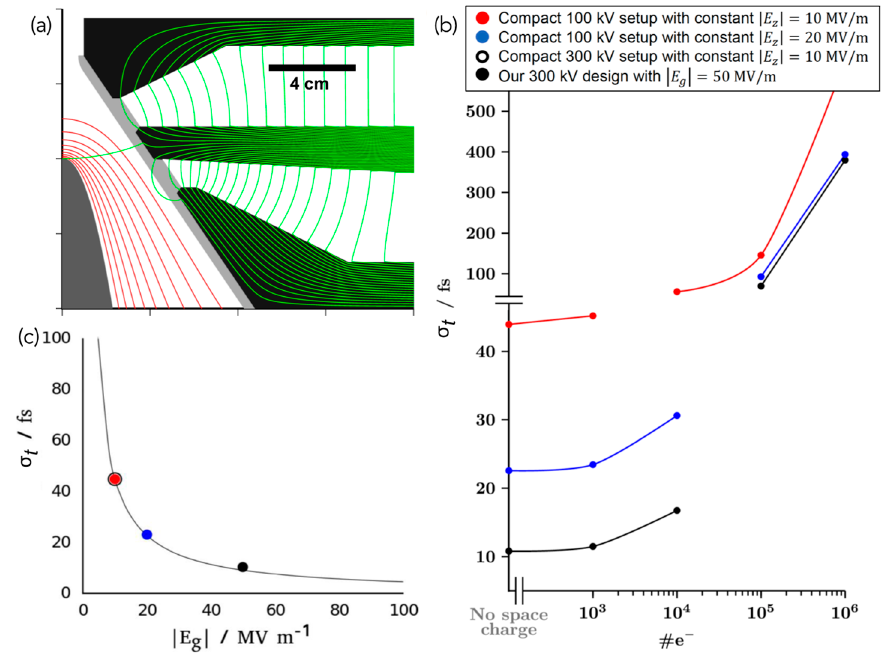
Figure 17. Ultrafast electron source concept for the generation of <15-fs (rms) multi-electron bursts. ( a ) Schematic of the electron source concept. Equipotential and magnetic field lines calculated using Poisson Superfish, [226] are shown in red and green, respectively with a value of (cid:12) E g (cid:12) = 50 MV m –1 . ( b , c ) Results from ASTRA simulations. (b) Electron pulse duration ( σ t , in fs) as a function of the number of electrons per bunch (#e – ). Black trace corresponds to our 300-kV DC FED design with d a = 5 cm and a total cathode-sample distance d T = 10 cm. Blue and red traces correspond to compact 100 kV DC FED setups (with flat electrodes) with d T = 2 cm and constant electrostatic fields of | E z | = 20 MV m –1 and 10 MV m –1 , respectively. ( c ) Dependence of electron pulse duration (without space-charge effects) as a function of (cid:12) E g (cid:12) . Electrons in simulations were generated at the cathode surface considering a temporal (longitudinal) Gaussian profile of 6 fs (rms) [14 fs (fwhm)], an initial energy spread of 0.2 eV, and a lateral (transverse) Gaussian spot size of 50 µ m (rms). The solid trace in panel ( c ) was obtained from a fit implementing Equation (20). Figure adapted from Reference [224].